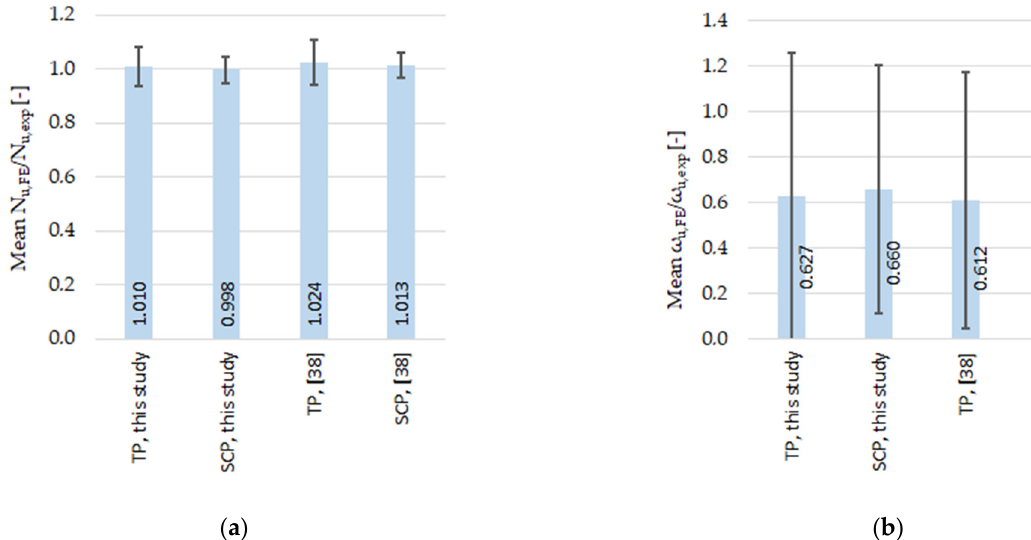
Figure 16. Average values with standard deviation bars for: ( a ) normalized ultimate loads; ( b ) normalized ultimate deflections; both depicted for the results considering SCP and TP material properties, based on this study and also the study by Mr. Buchanan [38].